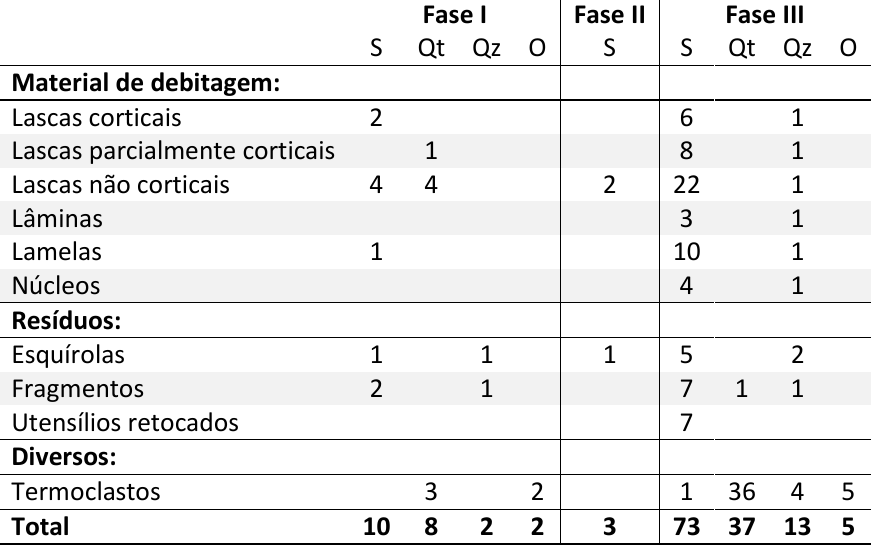
Table 1. Inventory of the knapped stone assemblage from Test 1, by raw material (S - flint; Qt - quartzite; Qz - quartz; O - others).